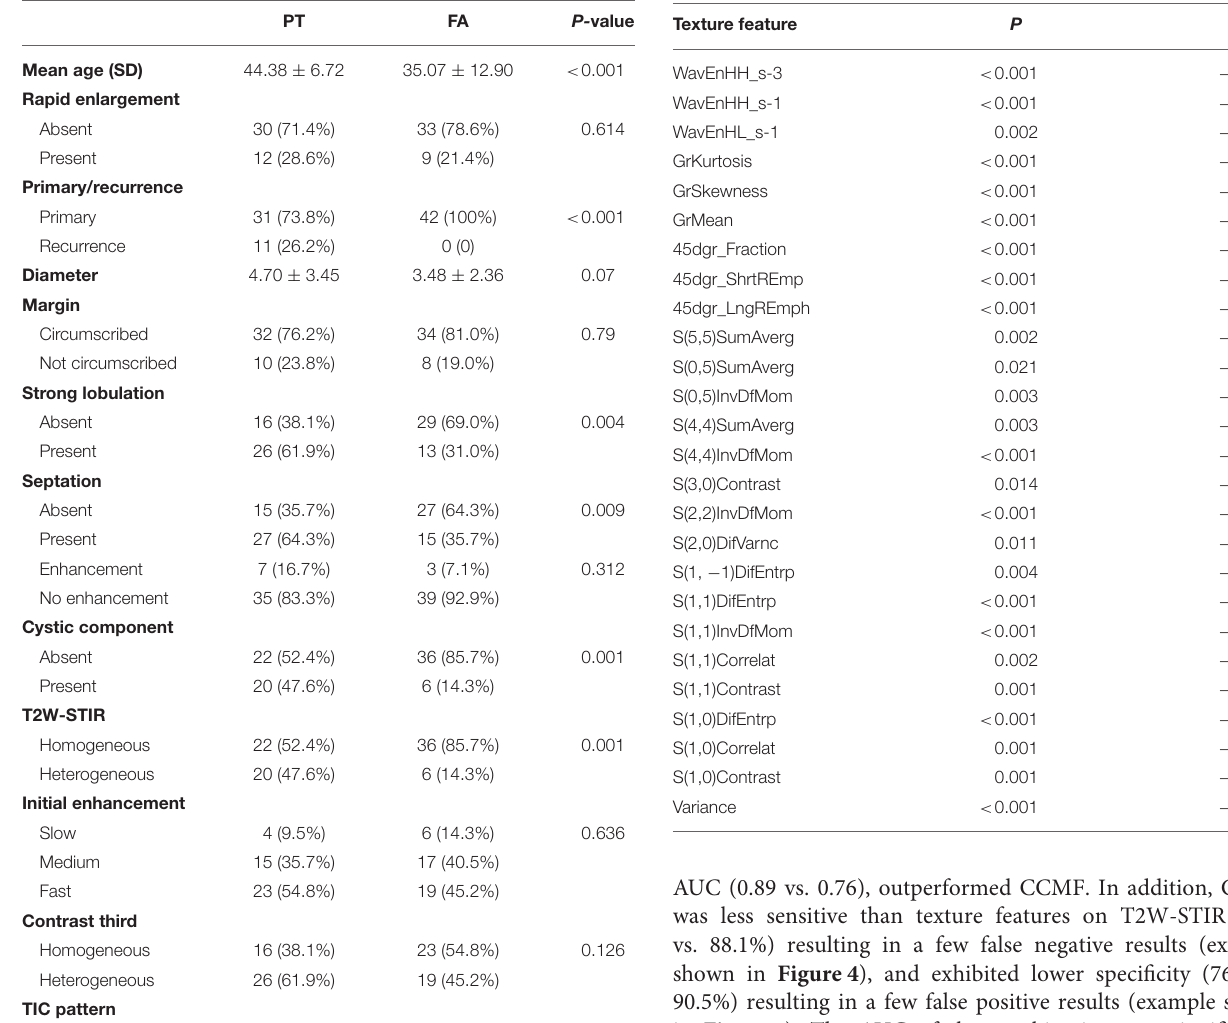
TABLE 3 | Statistically significant texture features on axial short TI inversion recovery T2-weighted